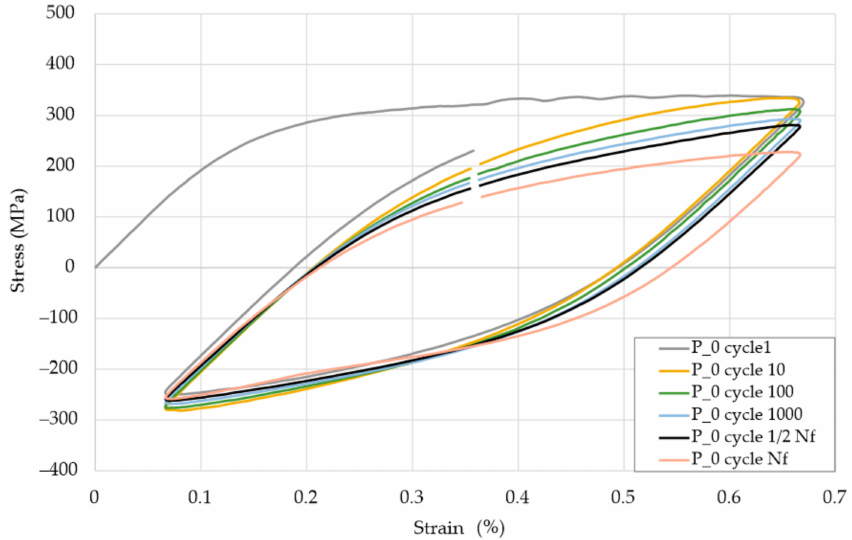
Figure 5. Hysteresis loops for selected cycles for ε ac = 0.3% for characteristic cycles during low cycle fatigue (LCF) testing.